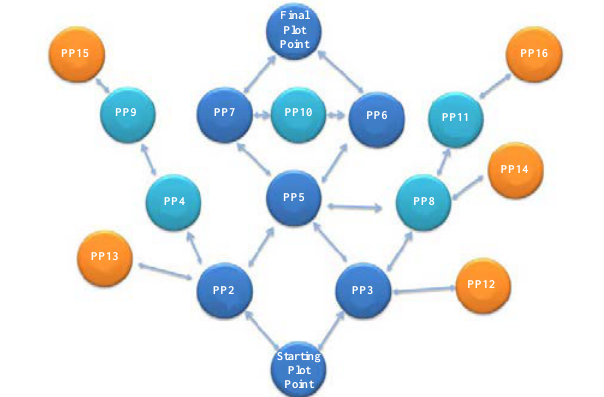
Some plot points can lead to side quests. These side quests can provide information, health point and fuel points.